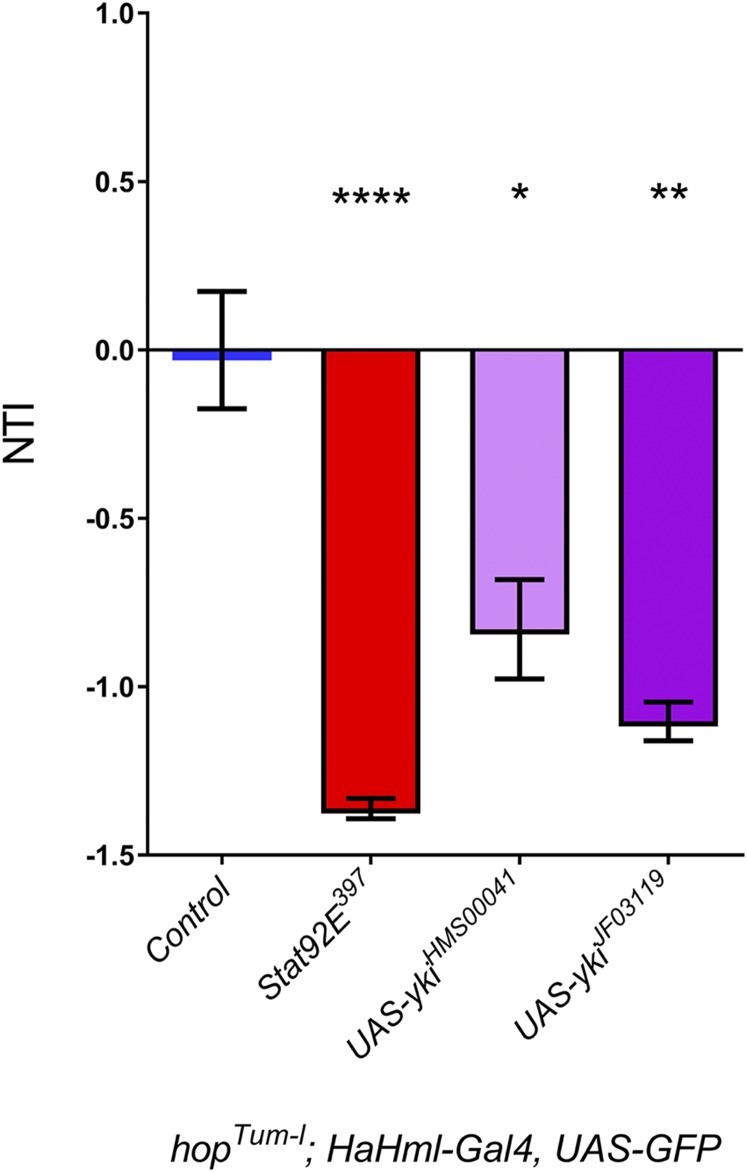
Hematopoietic depletion of Yki significantly lowers the tumor burden in hopTum-l animals. The first bar (blue bar) indicates the NTI in hopTum-l/+; HaHml > GFP/+ adult females (labeled “control”). Heterozygosity for Stat92E (red bar, genotype: hopTum-l/+; HaHml > GFP/+; Stat92E397/+) strongly suppresses the NTI (P < 0.0001). Hematopoietic depletion of Yki by RNAi (light purple bar, genotype: hopTum-l/+; HaHml > GFP/UAS-ykiHMS00041; dark purple bar hopTum-l/+; HaHml > GFP/UAS-ykiJF03119) significantly reduces the NTI (P < 0.0286 for ykiHMS00041 and P < 0.0023 for ykiJF03119). GFP, green fluorescent protein; NTI, normalized tumor index; UAS, upstream activating sequence; Yki, Yorkie.